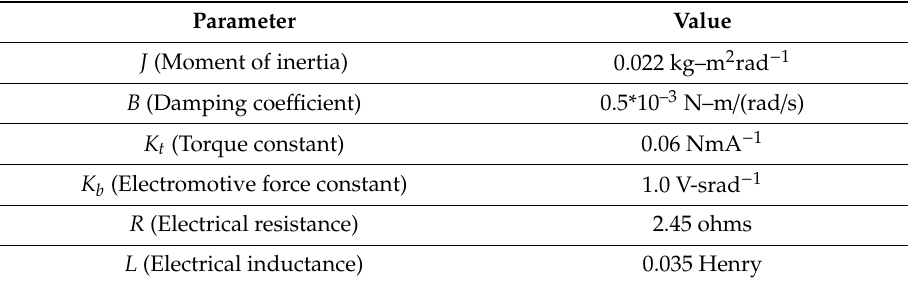
Table 2. DC motor specifications.